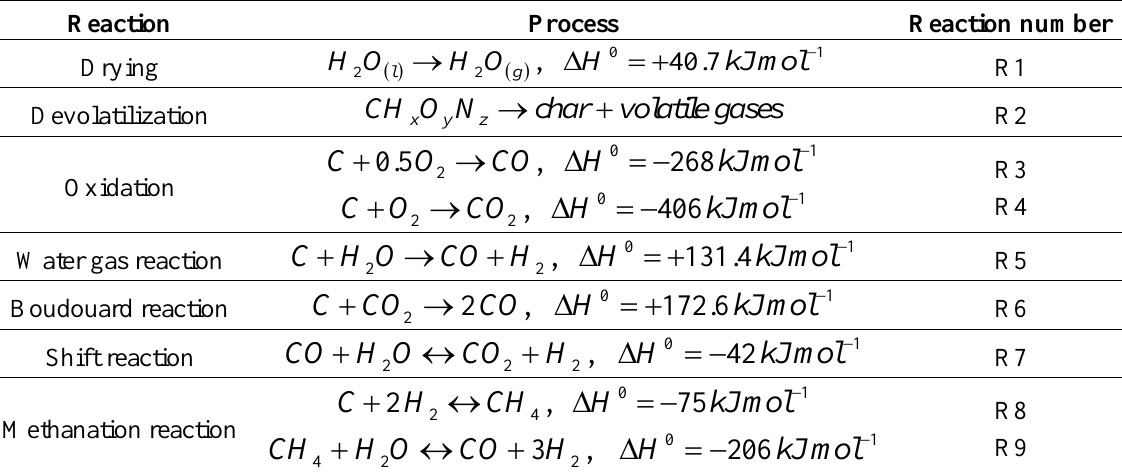
Table 2. A list of chemical reactions in the gasifier